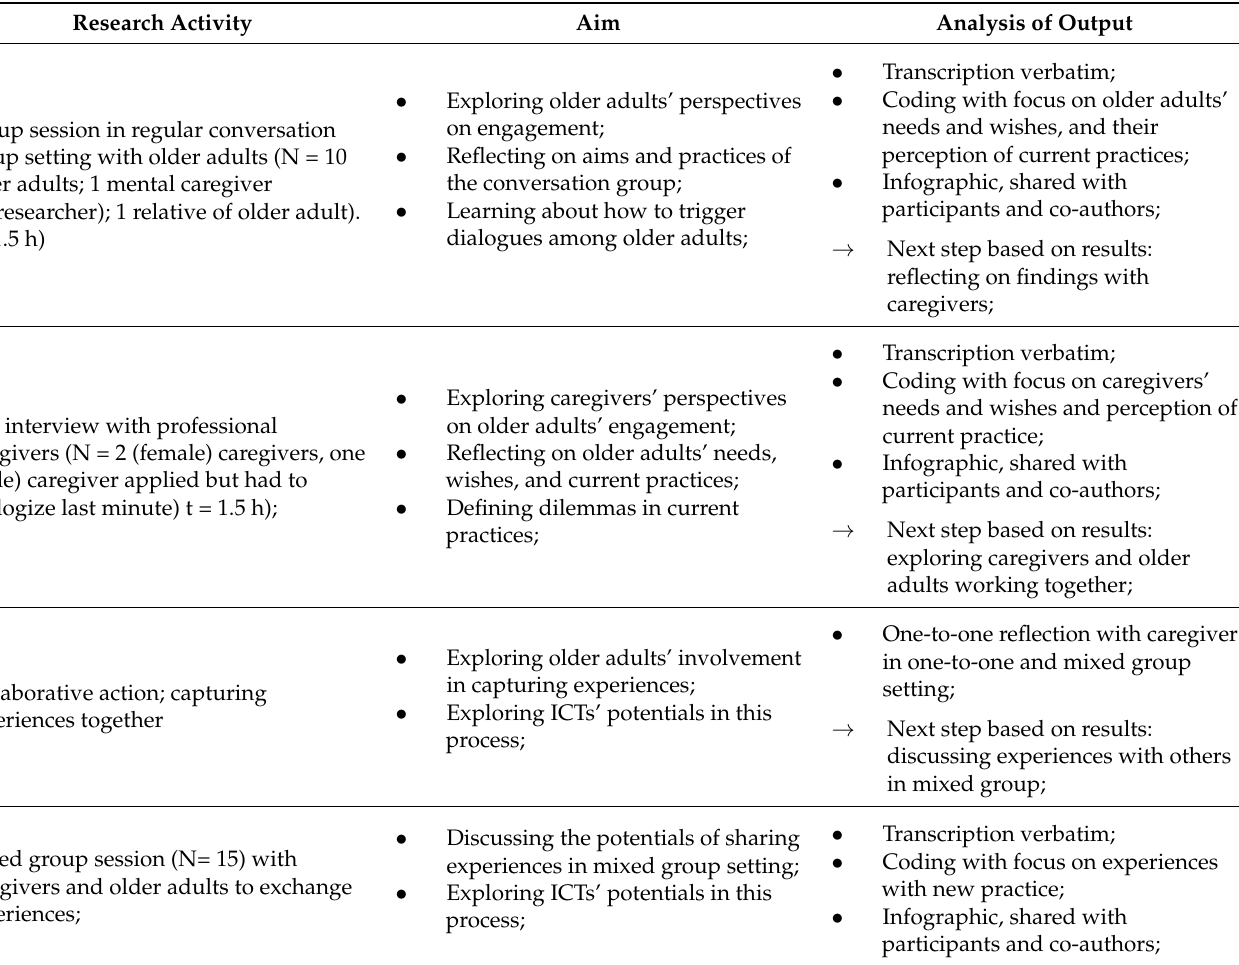
Table 1. Overview of the research